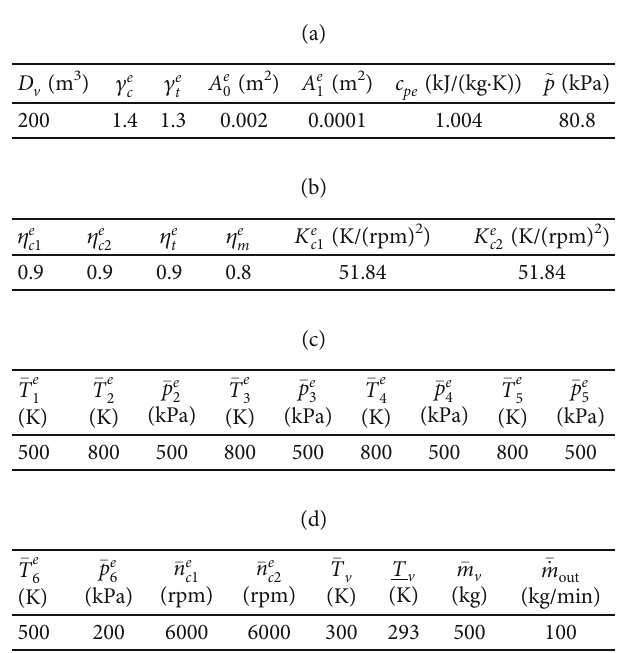
Table 3: Data for the fl ight phase.